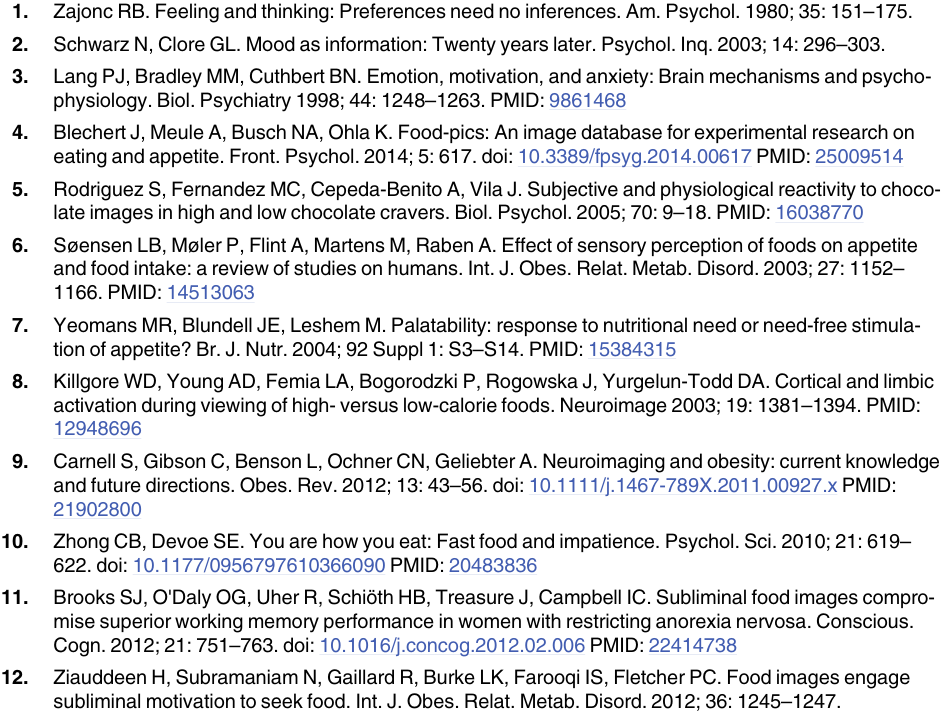
S2 Fig. Illustrations of the trial sequences of the subliminal food, subliminal mosaic, supra- liminal food, and supraliminal mosaic conditions. (TIF) S3 Fig. Mean (with 95% confidence interval) differences in preference ratings between food versus mosaic conditions under the subliminal (left) and supraliminal (right) presen- tation conditions. The ratings are for faces and food/mosaic stimuli under the subliminal and supraliminal presentation conditions, respectively.